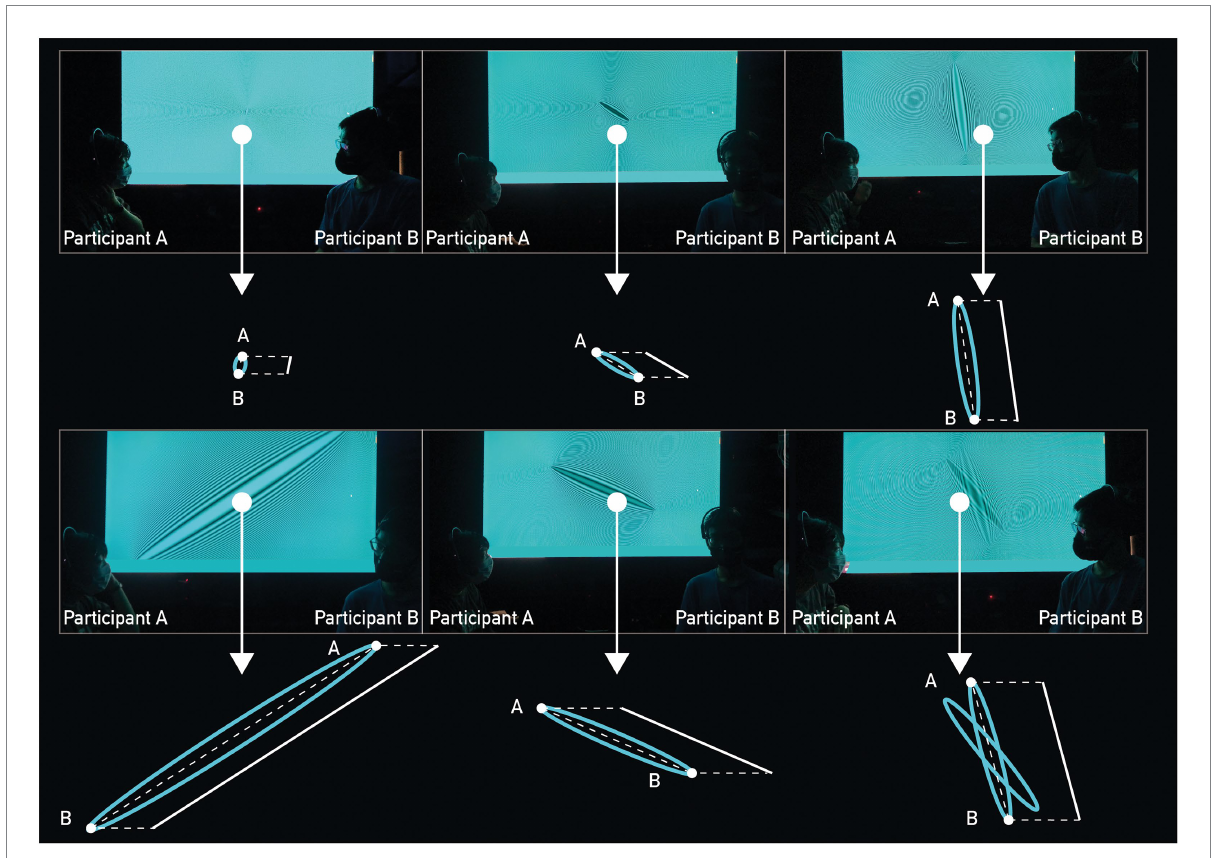
FIGURE 2 We transformed the difference between the electroencephalography (EEG) signals of participant A and participant B into the moiré pattern, and the pattern displayed six different states on the monitor (the images of the six states are six randomly selected time